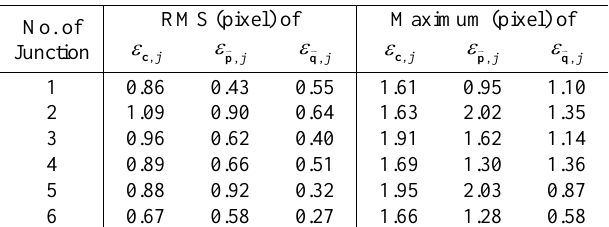
Figure 7. The ortho-maps, the LiDAR pointclouds, and the L-junction distributions ( : HCJ, : HICJ, : VCJ, : VICJ) of (a) Guangzhou dataset and (b) Ningbo